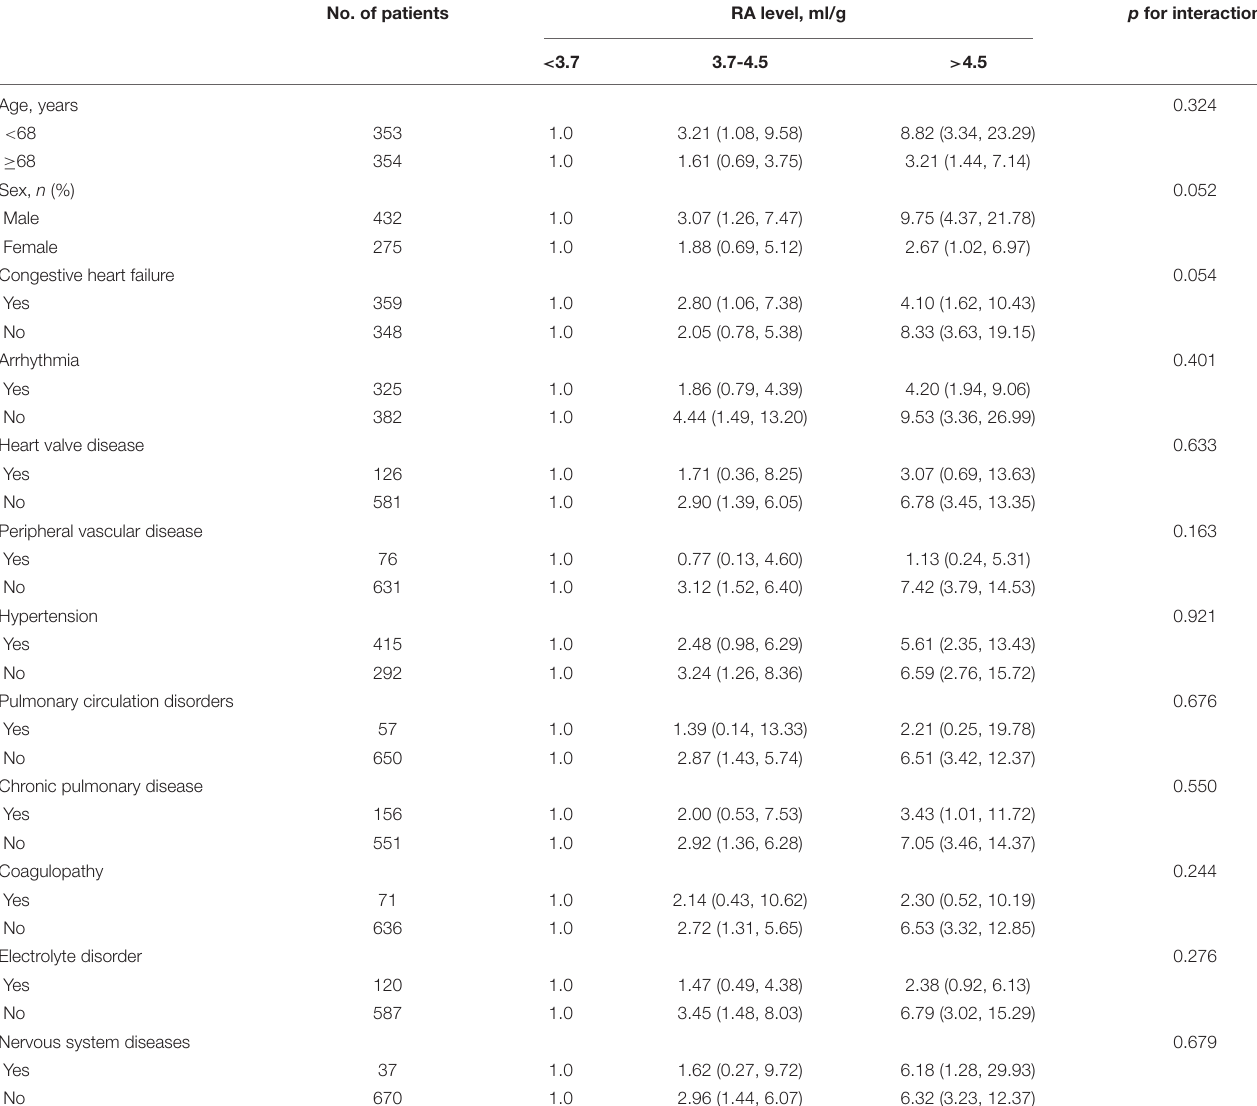
TABLE 3 | Subgroup analysis of the associations between 90-day all-cause mortality and the RA